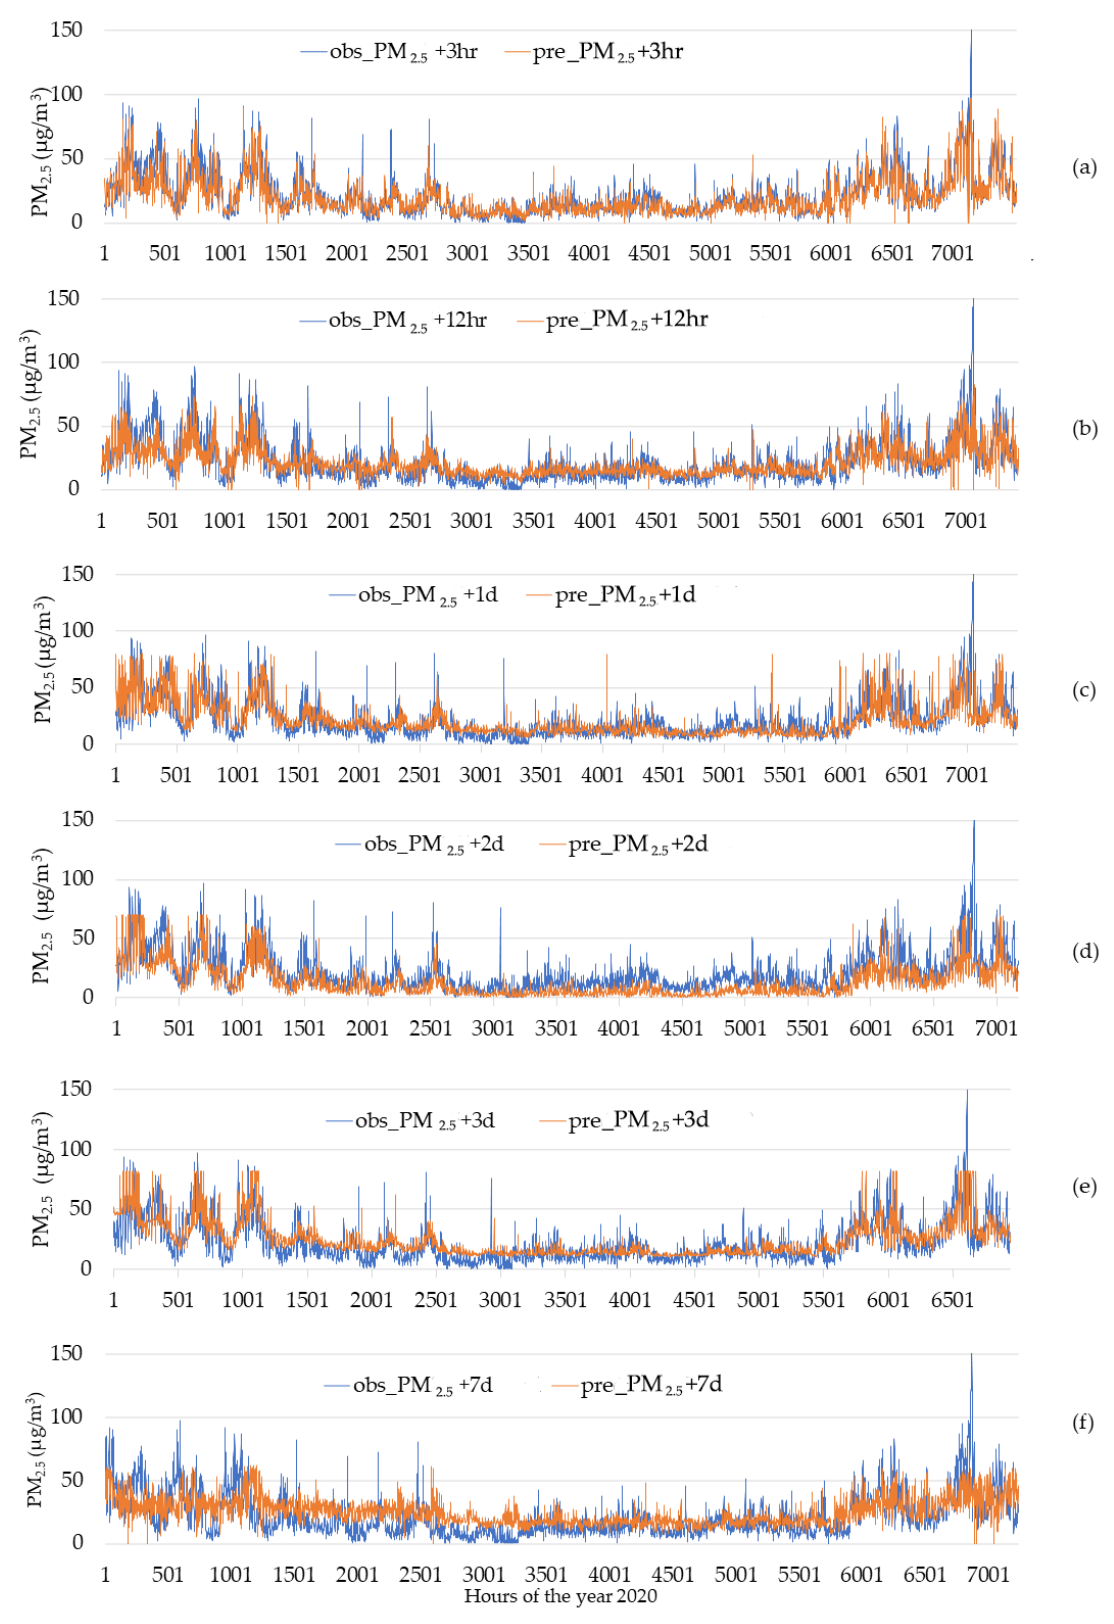
Figure 8. Variations between observed PM 2.5 concentrations and PM 2.5 concentrations predicted using the multilayer perceptron method. Forward prediction for: ( a ) 3 h, ( b ) 12 h, ( c ) 1 day, ( d ) 2 days, ( e ) 2 days, ( f ) 7 days